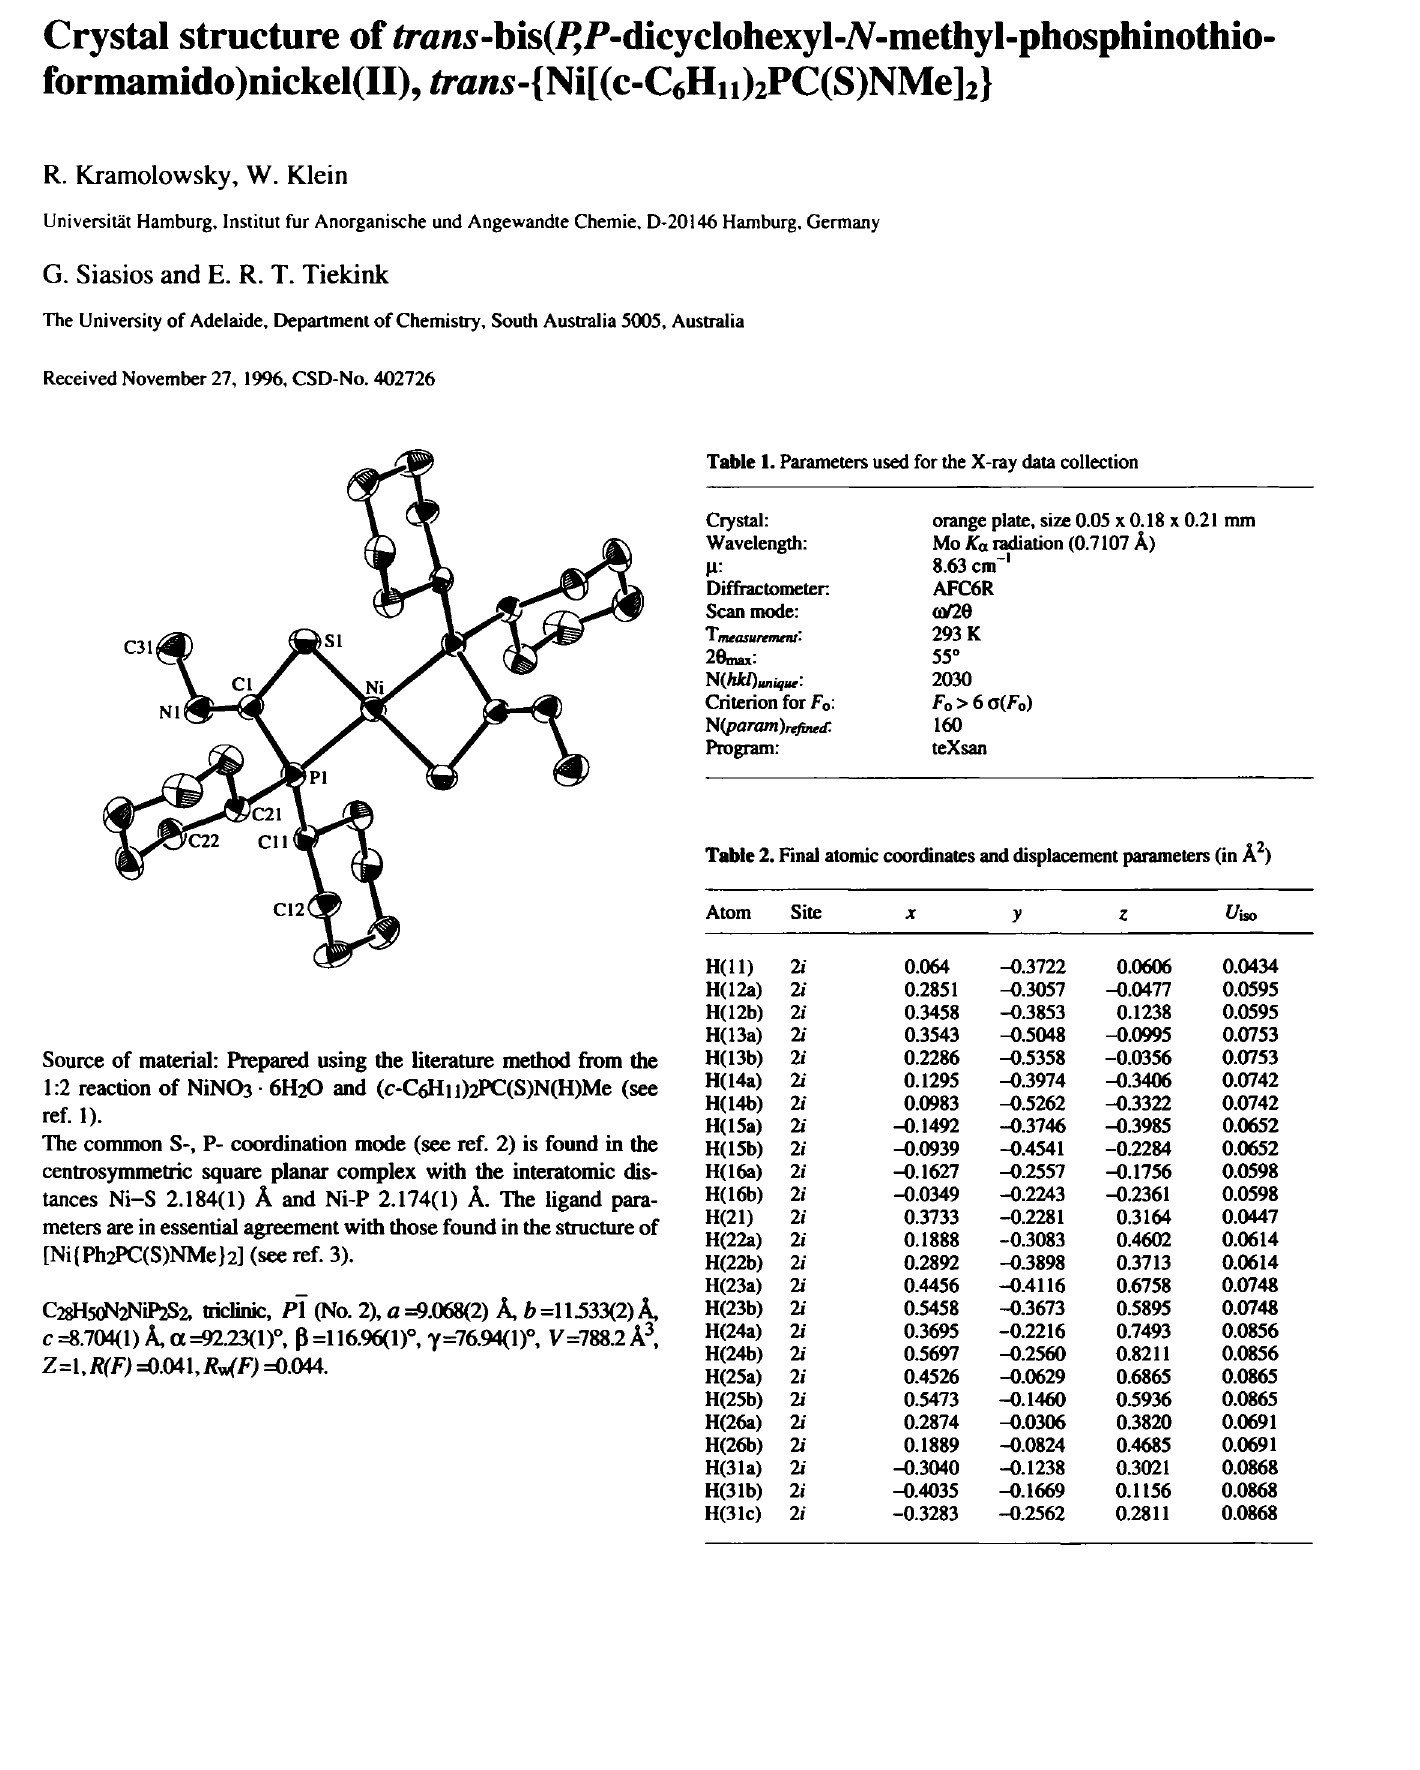
Table 1. Parameters used for the X-ray data collection Crystal: